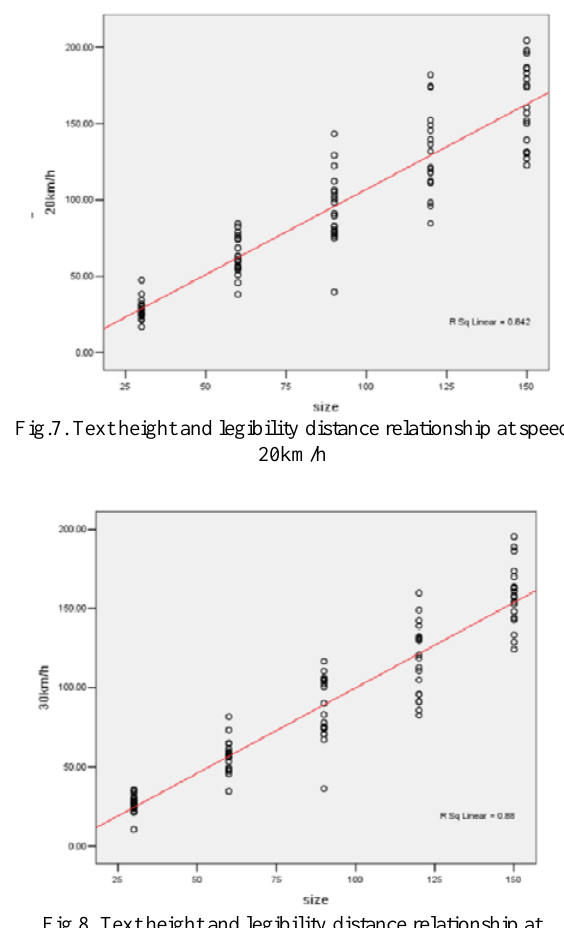
Fig.8. Text height and legibility distance relationship